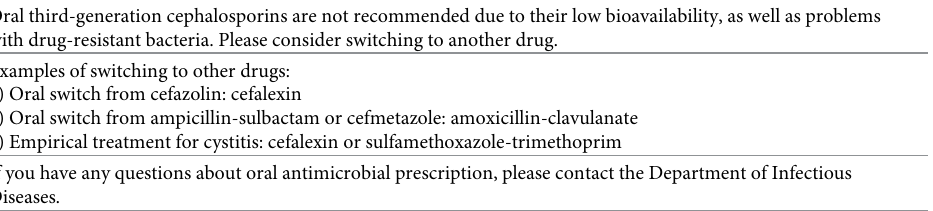
Table 1. Pop-up for oral 3GC prescription. Oral third-generation cephalosporins are not recommended due to their low bioavailability, as well as problems with drug-resistant bacteria. Please consider switching to another drug. Examples of switching to other drugs: 1) Oral switch from cefazolin: